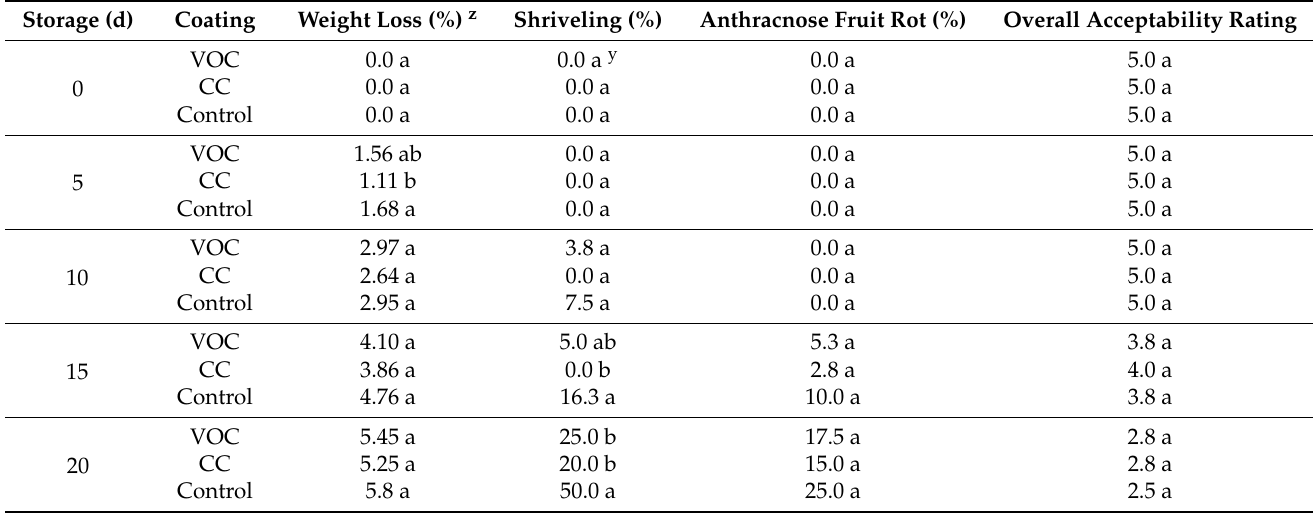
Table 1. Weight loss (%), shriveling (% surface area), anthracnose fruit rot (% surface area) and overall acceptability ratings (scale 1–5) for whole, coated and uncoated pitaya fruit during 20 days storage at 7 ◦ C.